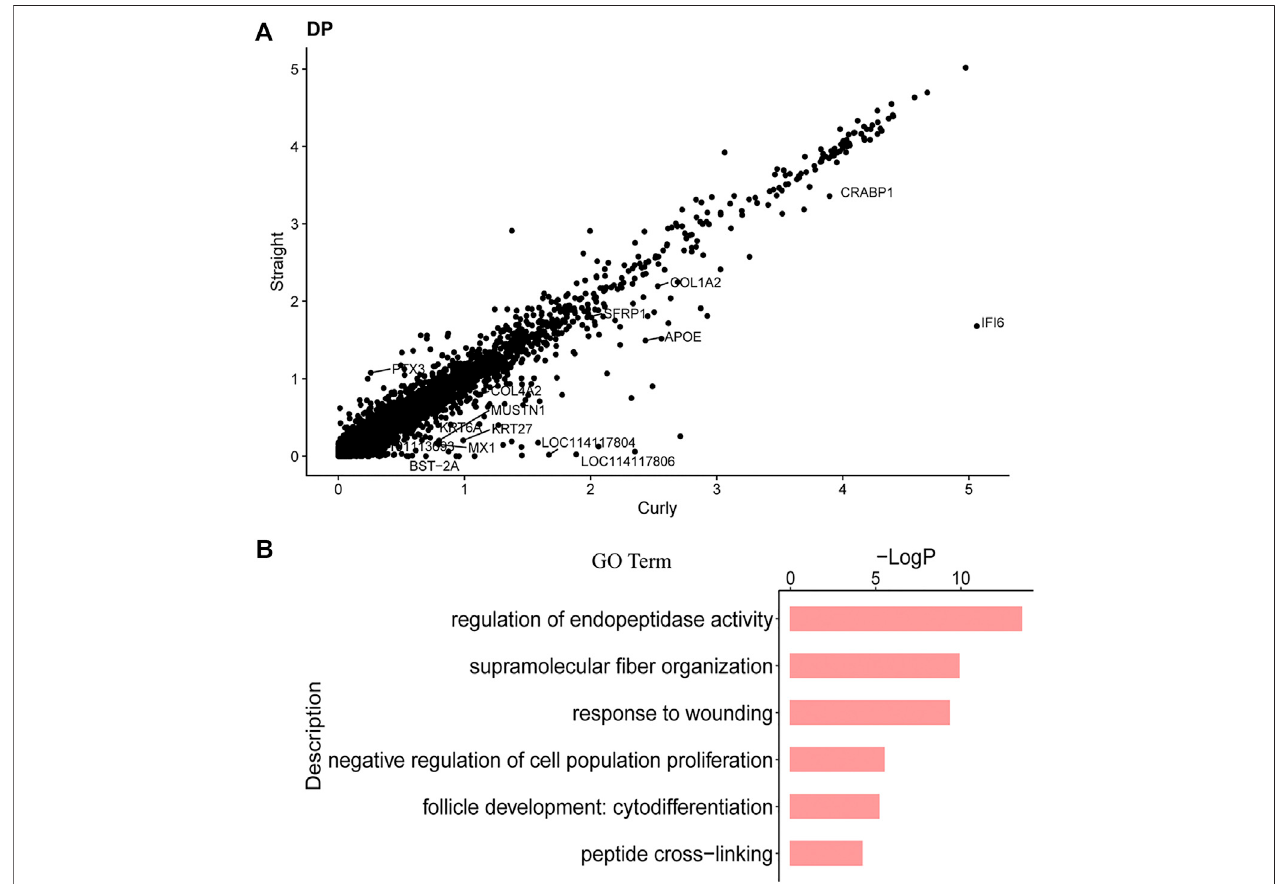
FIGURE 6 | DEGs in DPCs between Straight Wool and Curly Wool. (A) Scatter plots show genes that exhibit dramatic differentially expression. (B) GO terms for DEGs in DPCs between Straight Wool and Curly Wool.